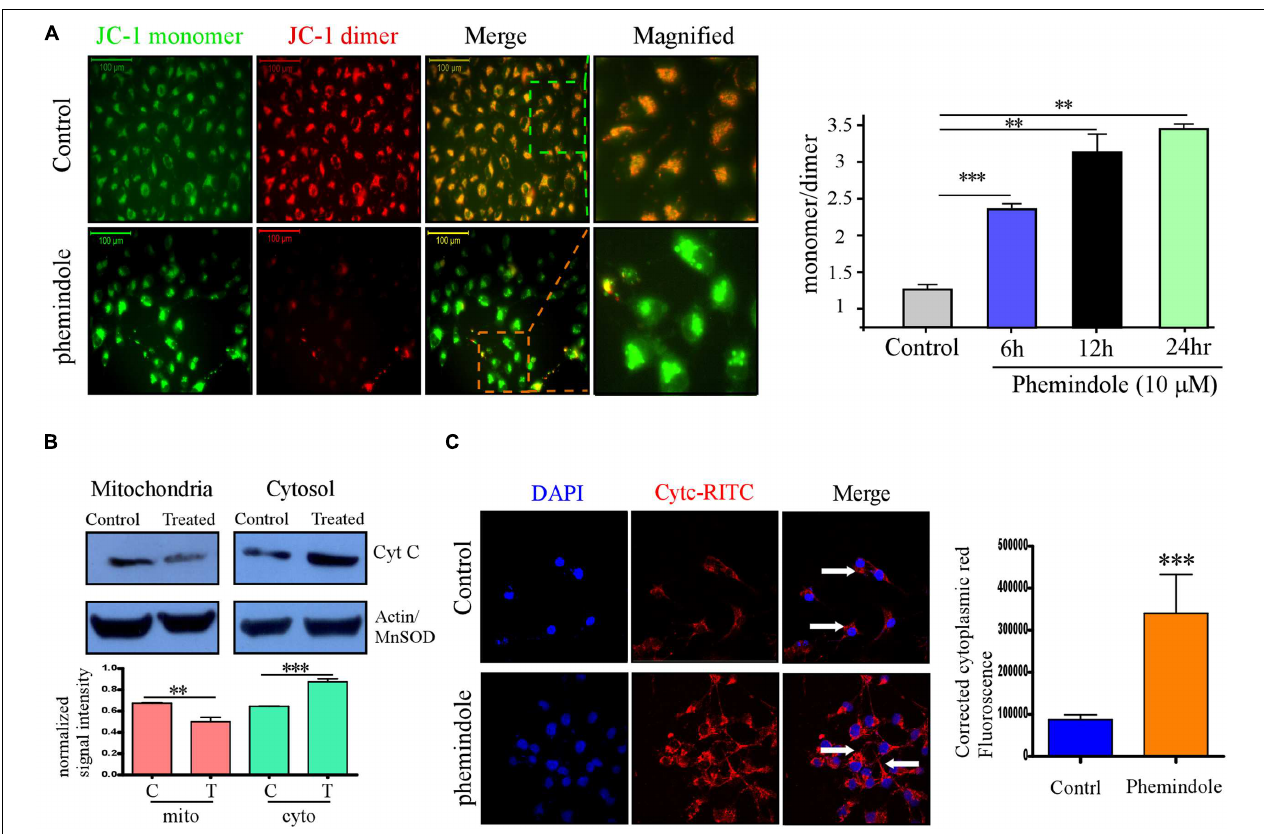
FIGURE 2 | Phemindole potentiates mitochondrial membrane potential depolarization and Cytochrome C release in MDAMB-231 cells. (A) Fluorescence microscopic images of the MDAMB-231 cells stained with JC-1 dye for detecting the changes in mitochondrial membrane potential in both control and Phemindole treated cells. The red fluorescence intensity in the Phemindole treated cells was weaker than in the control cells (Left panel). Bar diagram shows the quantitative monomer (Red Fluoroscence)/dimer (green fluorescence) ratio at different time point of Phemindole (10 µ M) treated set (Right panel). (B) Western blot assay showing Cyt C release (upper panel). The level of Cyt C increased in the cytoplasm and decreased in the mitochondria of the MDAMB-231 cells treated with the Phemindole, indicating that Phemindole caused the release of Cyt C from mitochondria. β -actin for cytosol and Mn-SOD for mitochondria were taken as positive control. Blots are representative of three independent experiments and quantifications are indicated by Bar diagram (lower panel). Values were normalized by intensity of positive control. (C) Immunofluorescence images of Cyt C –TRITC (Red) and DAPI (blue) staining in MDAMB-231 cells from untreated and Phemindole treated sets (Left panel). Pictures showed representative cells of each population and were representative of three independent experiments. Corrected cytoplasmic red Fluorescence intensity was quantified following the protocol described in material method section (Right panel). ∗ , ∗∗ , ∗∗∗ indicate p < 0.05, p < 0.01, p < 0.0005 versus untreated